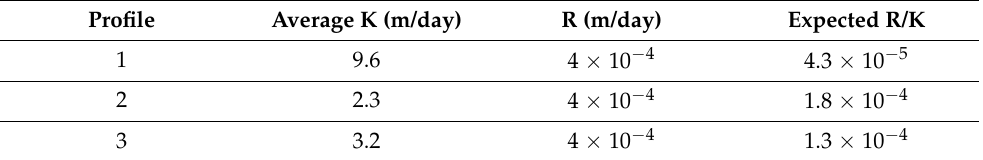
Table A3. Expected values for average hydraulic conductivity (K), recharge (R), and R/K ratios based on weighted average K [38] and recharge rates from